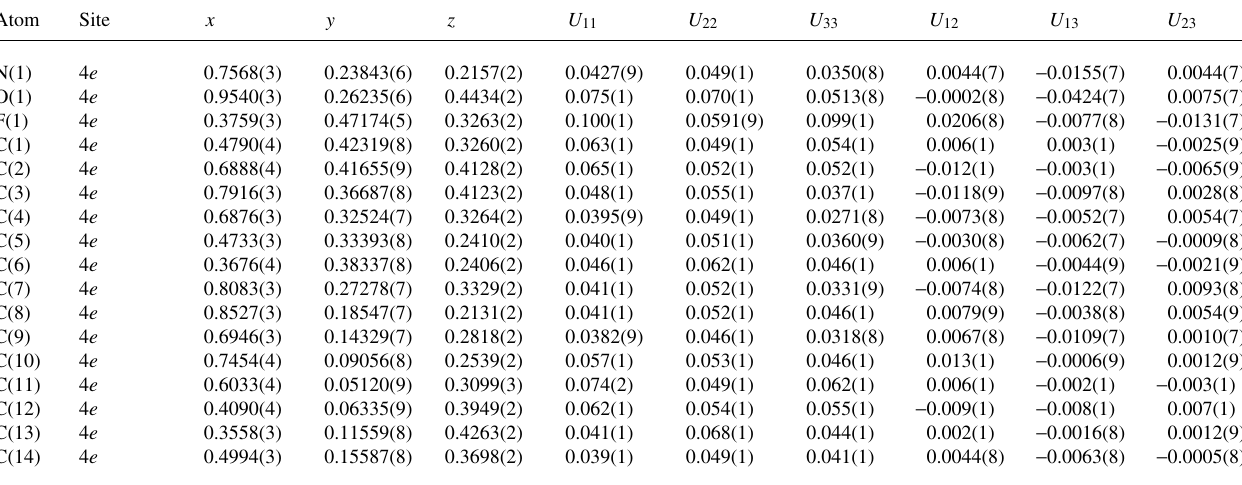
Table 3. Atomic coordinates and displacement parameters (in Å 2 )